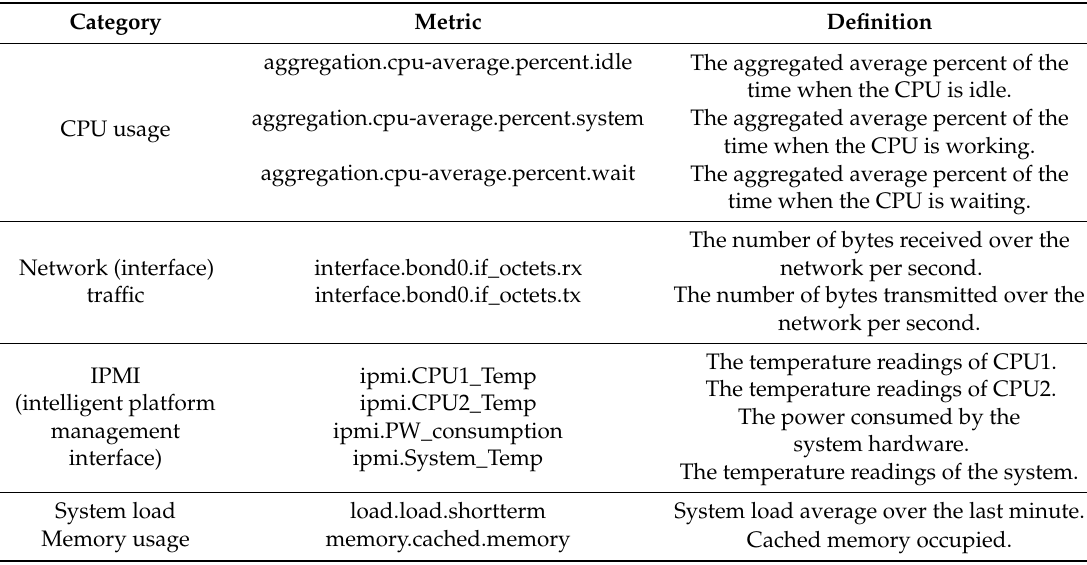
Table 1. Performance metrics